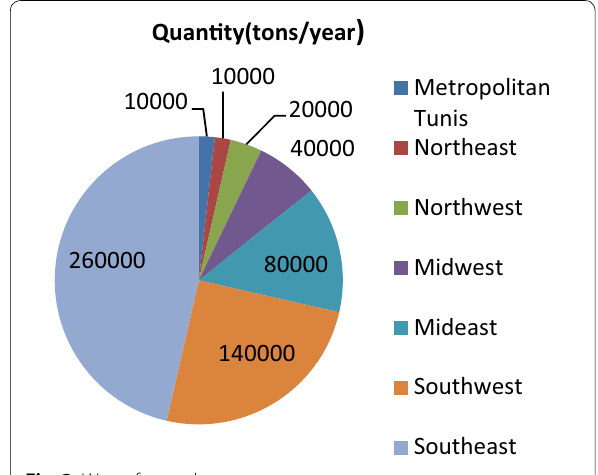
Fig. 3 Waste from urban green